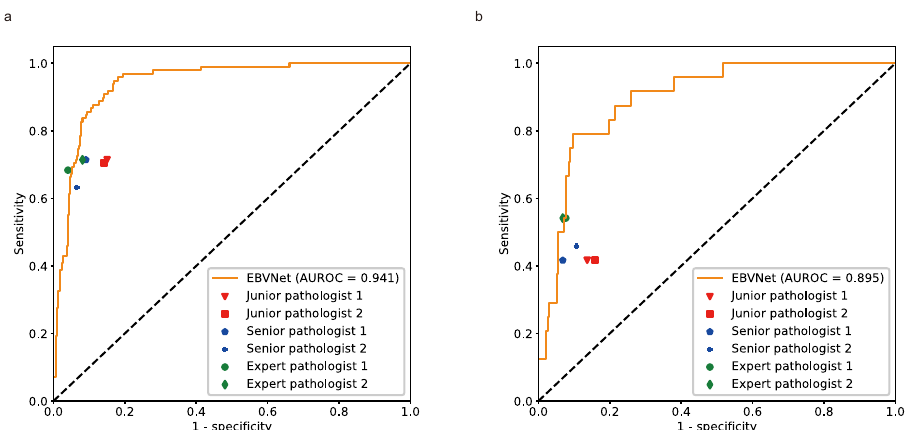
Fig. 2 Diagnostic performances of EBVNet and pathologists on two external datasets. a On the MultiCenter-STAD, the EBVNet achieved an AUROC of 0.941, outperforming all the six pathologists with an AUROC ranging from 0.782 to 0.821 ( P < 0.001, Delong ’ s test, two-sided). b On the TCGA-STAD, the EBVNet achieved an AUROC of 0.895, better than all the pathologists with an AUROC ranging from 0.629 to 0.737 ( P < 0.001, Delong ’ s test, two-sided). MultiCenter-STAD an external dataset from multiple medical centers, TCGA-STAD an external dataset from The Cancer Genome Atlas, AUROC area under the receiver operating